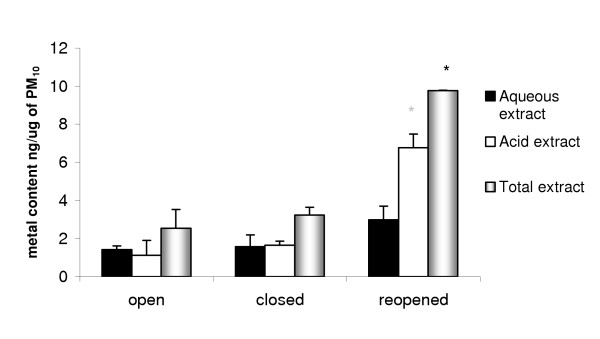
The measured metal content of 7 day PM10 samples collected before, during and after closure (* p < 0.05 compared to closure period). Extracts were made into ultra pure water (aqueous extract) followed by digestion of the remaining filter in HCl:HNO3(acid extract). Measurements were conducted by ICP-MS and values are the mean of 2 samples ± SEM.